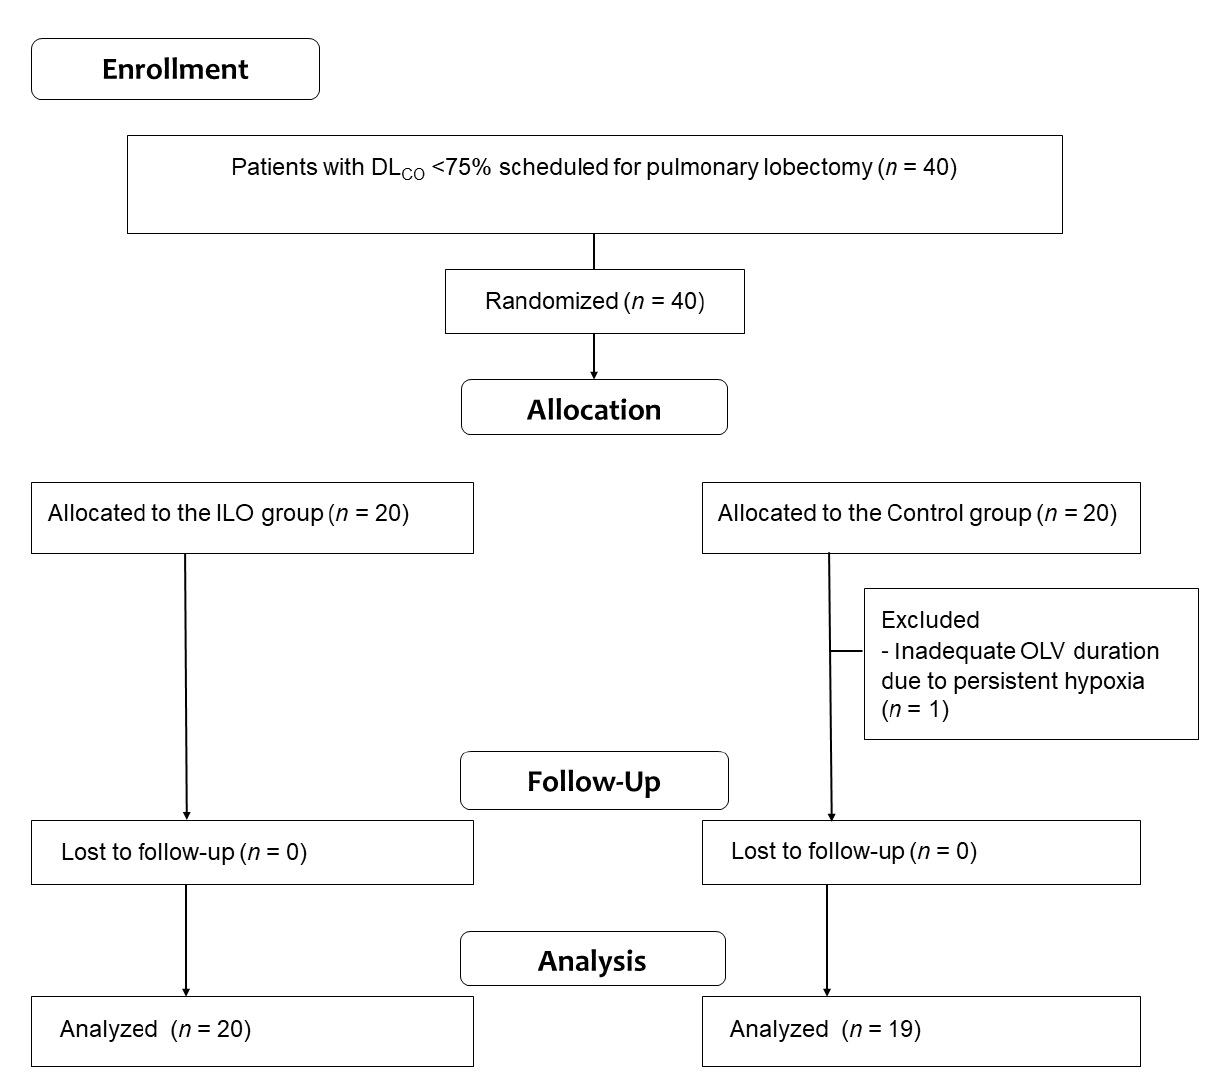
Figure 1. Patient Figure 1. Patient enrollment.